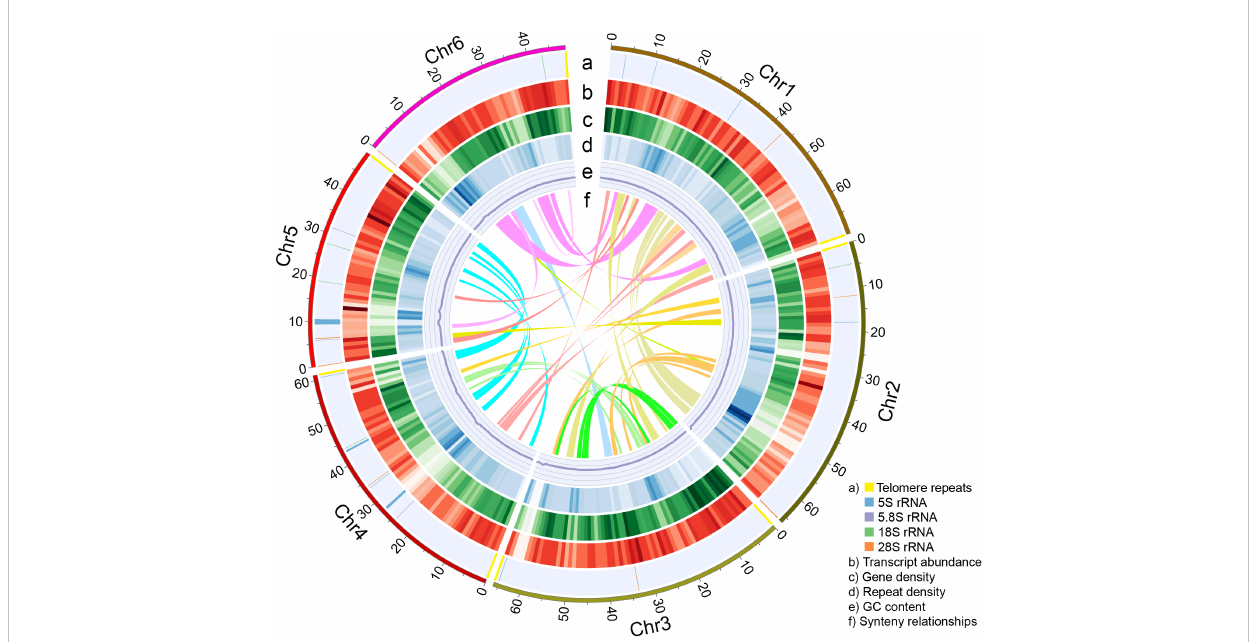
FIGURE 2 The nuclear genome of Shi_PSC_v1. Each ring indicates speci fi c features of the nuclear genome. Data from non-overlapping 1-Mb windows were graphed: (A) Position of telomere repeats and ribosomal RNA genes; (B) Average transcript abundance; (C) Gene density; (D) LTR density; (E) GC content; (F) Synteny blocks >1 Mb in